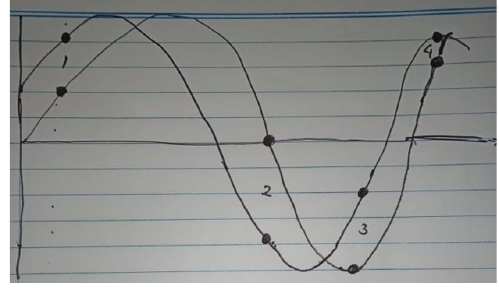
FIG. 10. Indra ’ s drawing as if the wave moves to the left.